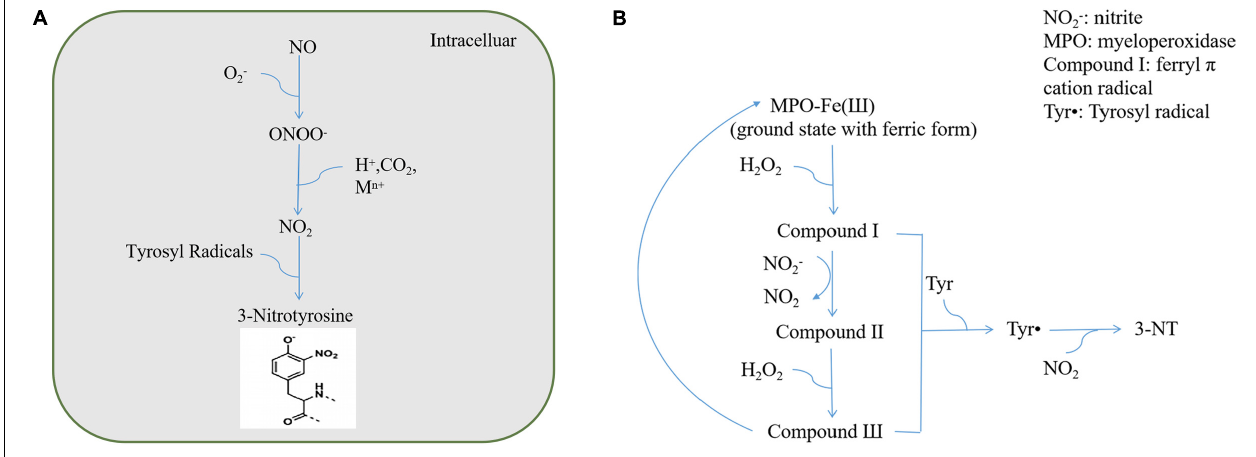
FIGURE 1 | (A) ONOO - reaction pathways. (B) NO 2 - /H 2 O 2 /heme peroxidase